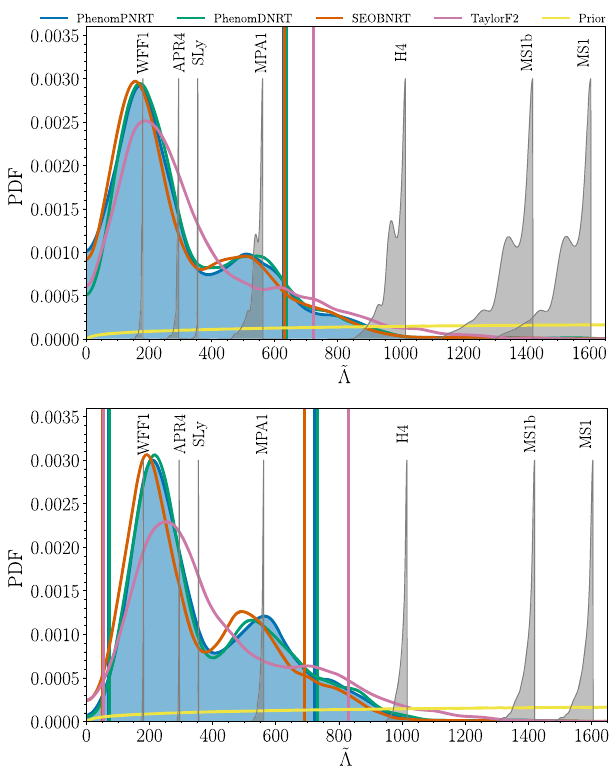
˜ Λ FIG. 11. PDFs of the combined tidal parameter for the high- spin (top panel) and low-spin (bottom panel) priors. Unlike in Fig. 6, the PDFs have been reweighted by dividing by the original ˜ Λ prior for (also shown). The 90% HPD credible intervals are represented by vertical lines for each of the four wave- form models: TaylorF2, PhenomDNRT, SEOBNRT, and PhenomPNRT. For the high-spin prior, the lower limit on the ˜ Λ ¼ 0 credible interval is . The seven gray PDFs are those for the seven representative EOSs using the masses estimated with the PhenomPNRT model. Their normalization constants have been rescaled to fit in the figure. For these EOSs, a 1 . 36 M ⊙ NS has a radius of 10.4 km (WFF1), 11.3 km (APR4), 11.7 km (SLy), 12.4 km (MPA1), 14.0 km (H4), 14.5 km (MS1b), and 14.9 km